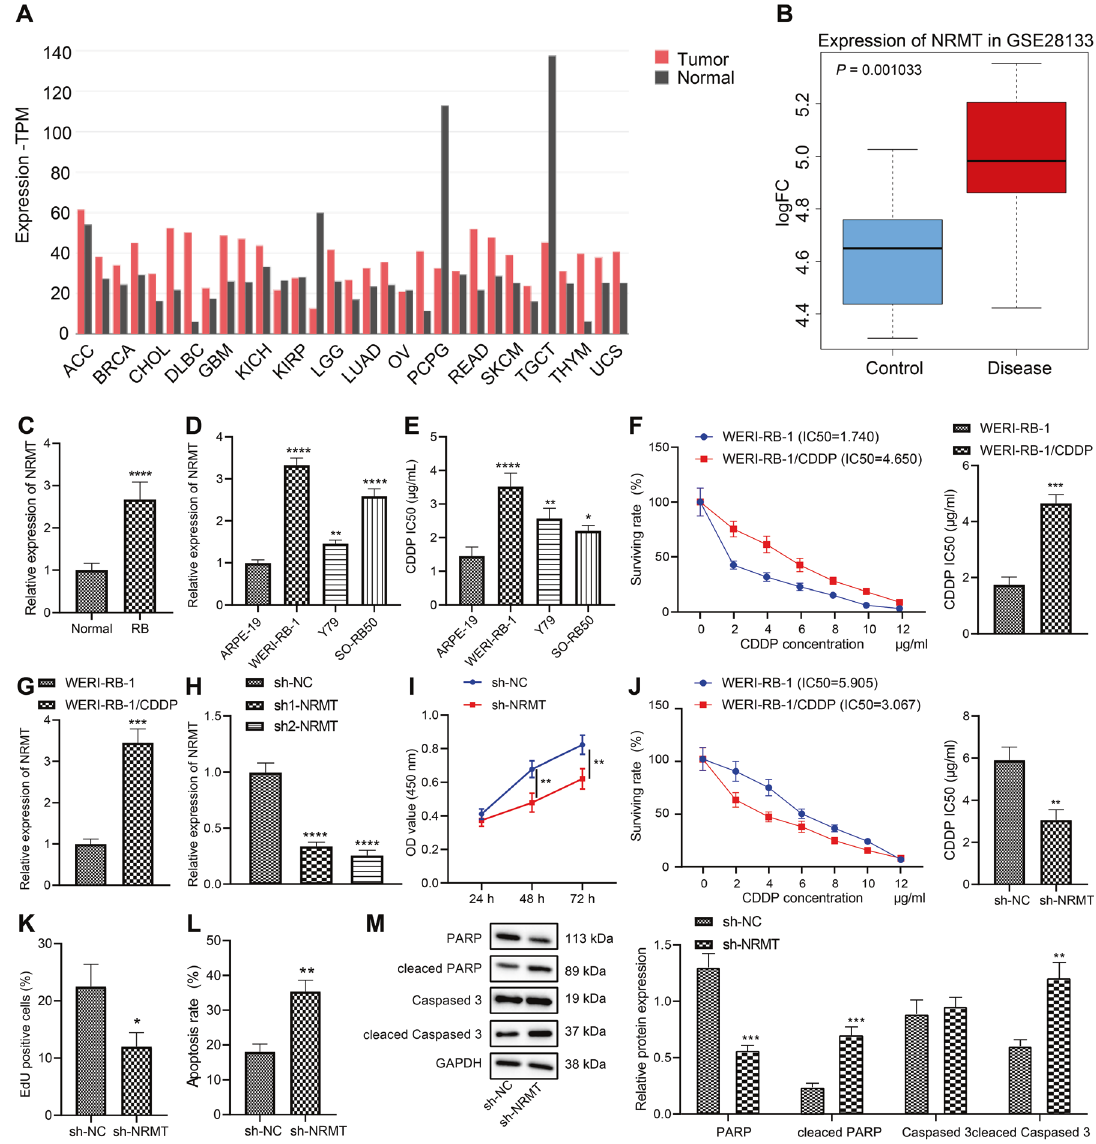
represents various cancer abbreviations, red represents high expression in this cancer species, green represents low expression, and black indicates that the difference is not signi fi cant. B Box plot of NRMT expression in normal (blue box) and diseased retina (red box) in microarray dataset GSE28133. C The expression of NRMT in retinoblastoma and normal control tissues determined by RT-qPCR, * p < 0.05 vs. normal tissues. D The expression of NRMT in retinoblastoma (WERI-RB-1, Y79, and SO-RB50) and normal cell line ARPE-19 determined by RT-qPCR, * p < 0.05 vs. ARPE-19 cell line. E Sensitivity of WERI-RB-1 cells to CDDP shown by IC 50 values after CDDP treatment assessed using CCK8. F IC 50 values of WERI-RB-1 and WERI-RB-1/CDDP cell lines. G The expression of NRMT in WERI-RB-1 and WERI-RB-1/CDDP cell lines determined by RT- qPCR. H The expression of NRMT in WERI-RB-1/CDDP cells after transfection with sh-NRMT. I Cell viability after transfection with sh-NRMT assessed using CCK8 method. J IC 50 values of cells after transfection with sh-NRMT measured by CCK8 assay. K Cell proliferation after transfection with sh-NRMT evaluated using EdU labeling assay. L Flow cytometric analysis of cell apoptosis after transfection with sh-NRMT. * p < 0.05 vs. cells transfected with sh-NC. M Expression of PARP, Cleaved PARP, caspase 3, and Cleaved caspase 3 in cells after transfection with sh-NRMT determined by western blot analysis. */# p < 0.05; **/## p < 0.01; ***/### p < 0.001; ****/#### p < 0.0001. The experiment was independently repeated three